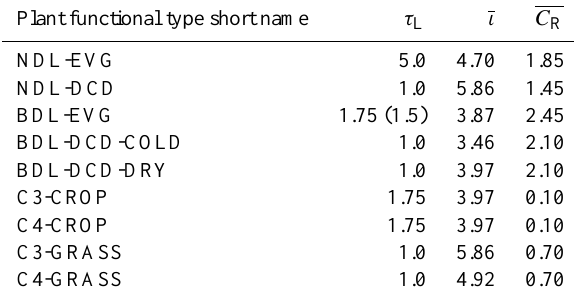
Table A6. PFT-specific leaf lifespans ( τ L , yr, Eq. A56) and mean root distribution profile ( ι , dimensionless) and average root biomass (C R , kgCm − 2 ) used to determine root distribution profile in Eq. (A60) for conversion of biomass to structural vegetation at- tributes in CTEM v. 2.0. Some parameter values differ between the model versions when PFTs’ fractional coverage is specified and when they are dynamically modelled using competition between PFTs. If modified, the parameter values for the dynamically mod- elled version are shown in